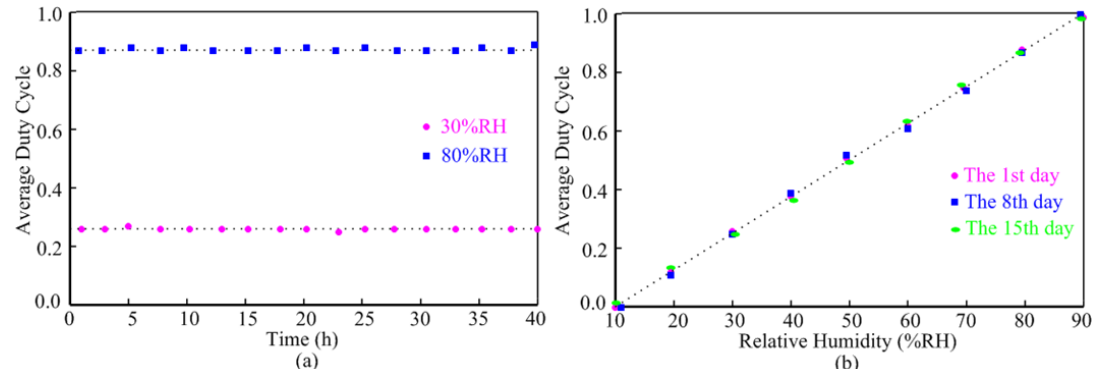
Figure 9. Stability measurement of the humidity sensor: ( a ) short-term stability; ( b ) long-term